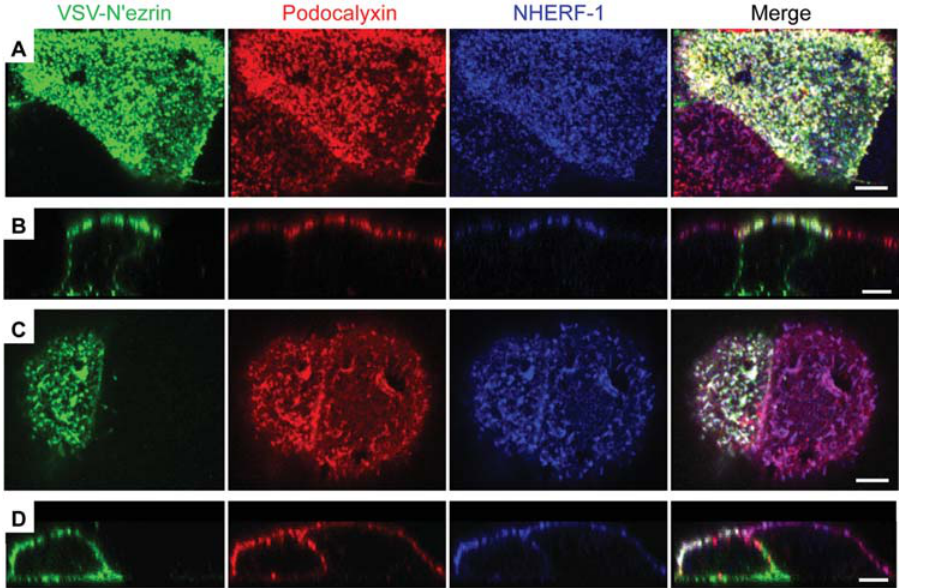
Figure 5. Apical localization of Podocalyxin and NHERF-1 is not dependent on ezrin. MCF-7 cells stably expressing ectopic murine Podocalyxin were either transfected with VSV-tagged dominant negative (N-terminal) ezrin after formation of monolayers and appropriate localization of Podocalyxin and NHERF-1 (A, B) or transfected with VSV-tagged N’ezrin and then replated before immunostaining (C, D). (A–D) Immunolabeling of VSV-tagged N’ezrin (green), ectopic Podocalyxin (red), and endogenous NHERF-1 (blue). Purple represents apical colocalization of Podocalyxin and NHERF-1 in cells not expressing dominant negative ezrin (internal negative control); white represents apical colocalization of all three molecules in cells expressing dominant negative ezrin. Scale bars: 5 m m. (A, C) Projections of merged confocal stacks taken near the apical cell surface showing individual colors and merged images; (B, D) vertical slices of confocal stacks.